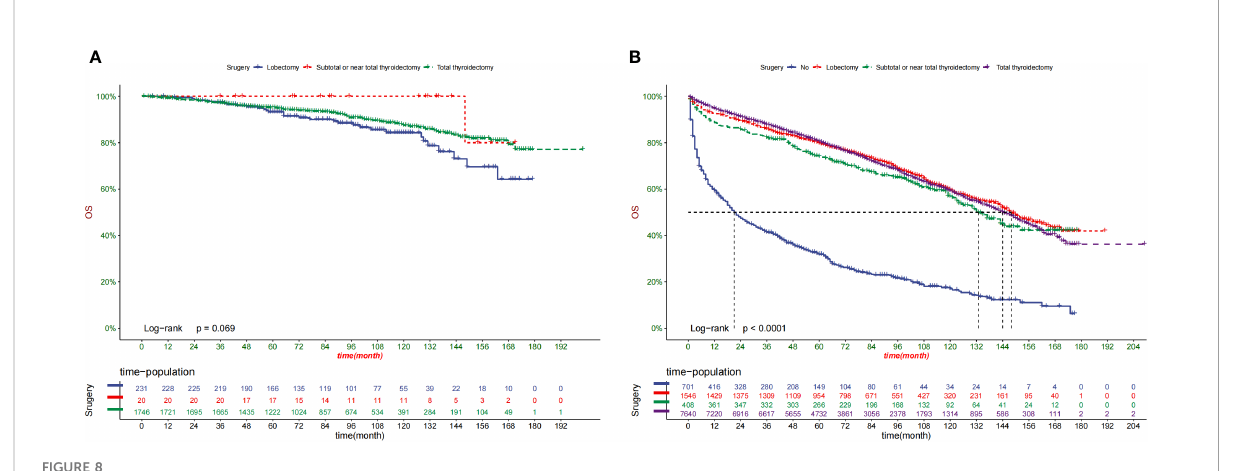
FIGURE 8 OS prediction of patients with different surgery in low- (A) and high-risk (B)